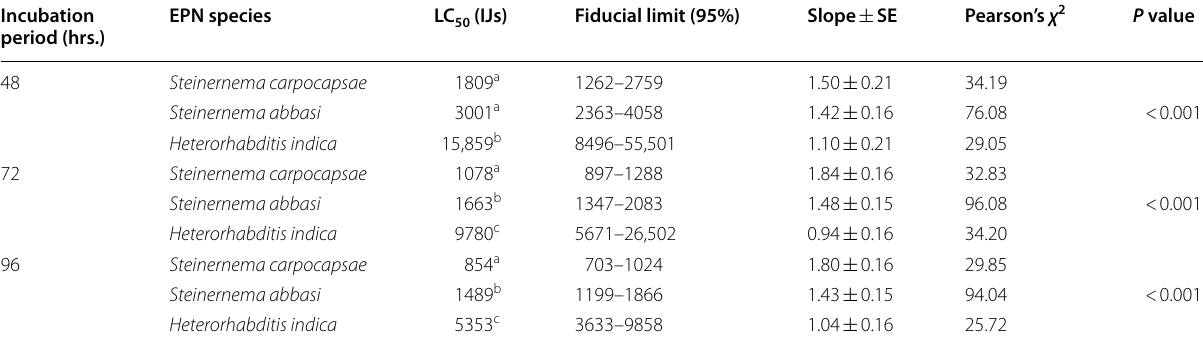
) of different nematode strain against 3rd instar larvae Oryctes rhinoceros at 48, 72 and 96 h 50 12) =